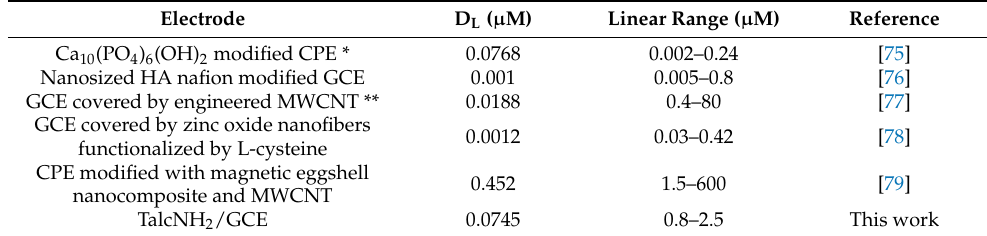
Figure 12. ( a ) Differential pulse anodic stripping voltammetry (DPASV) response of the TalcNH 2 /GCE at different concentrations of Pb 2+ ions under optimal conditions (insert corresponding to calibration curve). The experiments were conducted in triplicate. ( b ) Series of 5 DPASV response of 5 µ M Pb 2+ , recorded in 0.1 M HCl after 1 min accumulation in pH 6 aqueous solution. Table 2. Comparison of the performance of some Pb 2+ ion sensors.